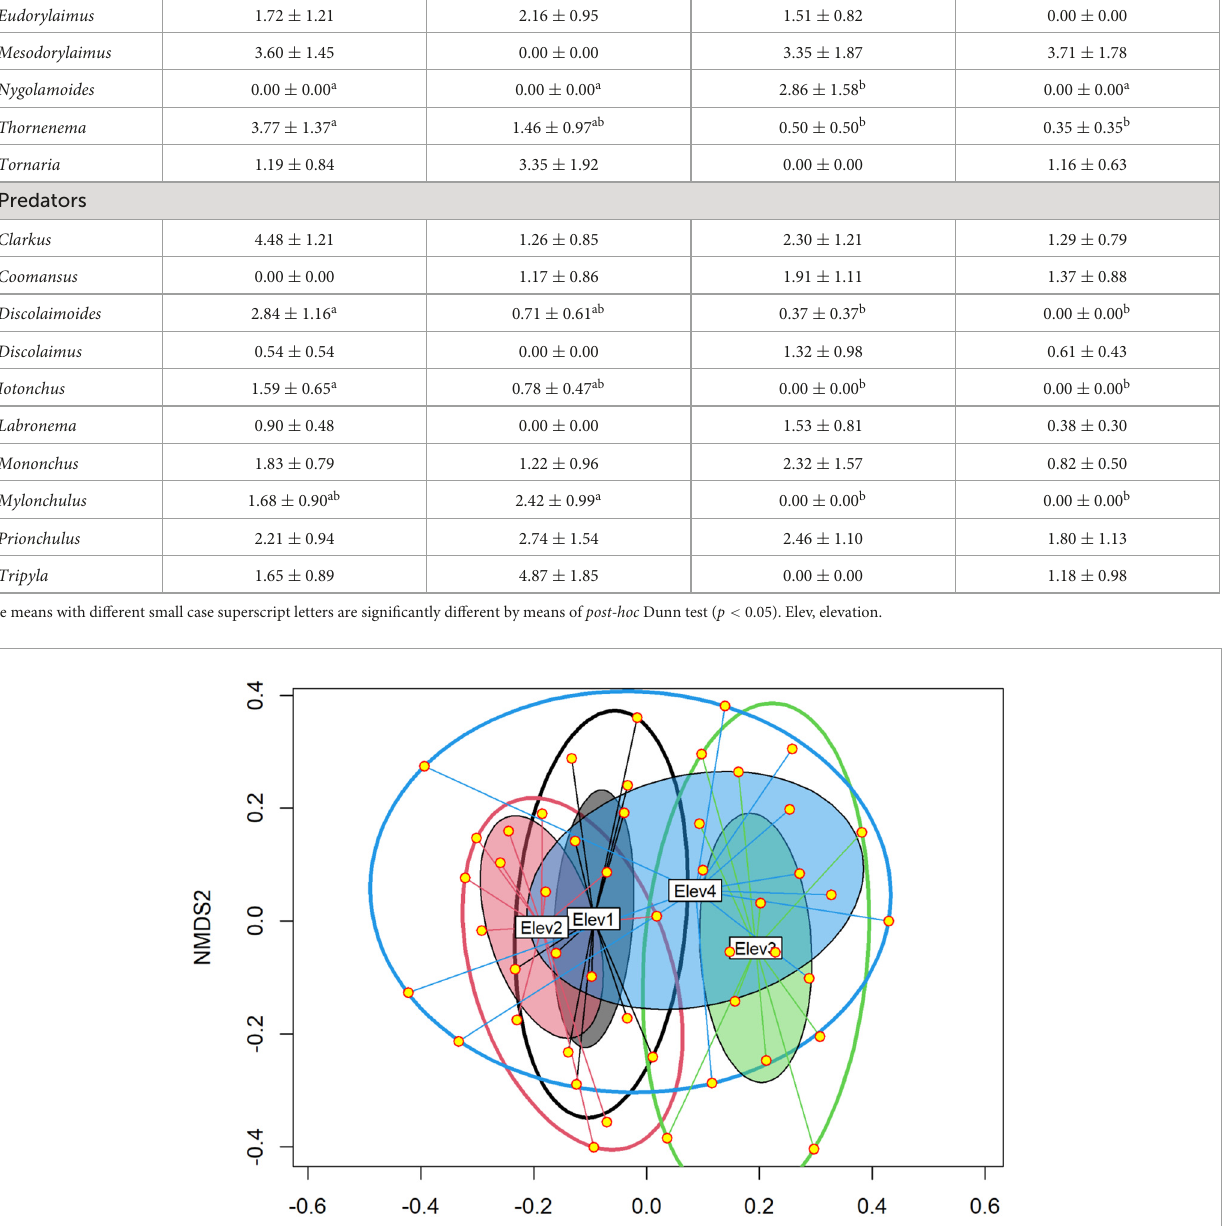
temperature were significantly higher at the lower elevation